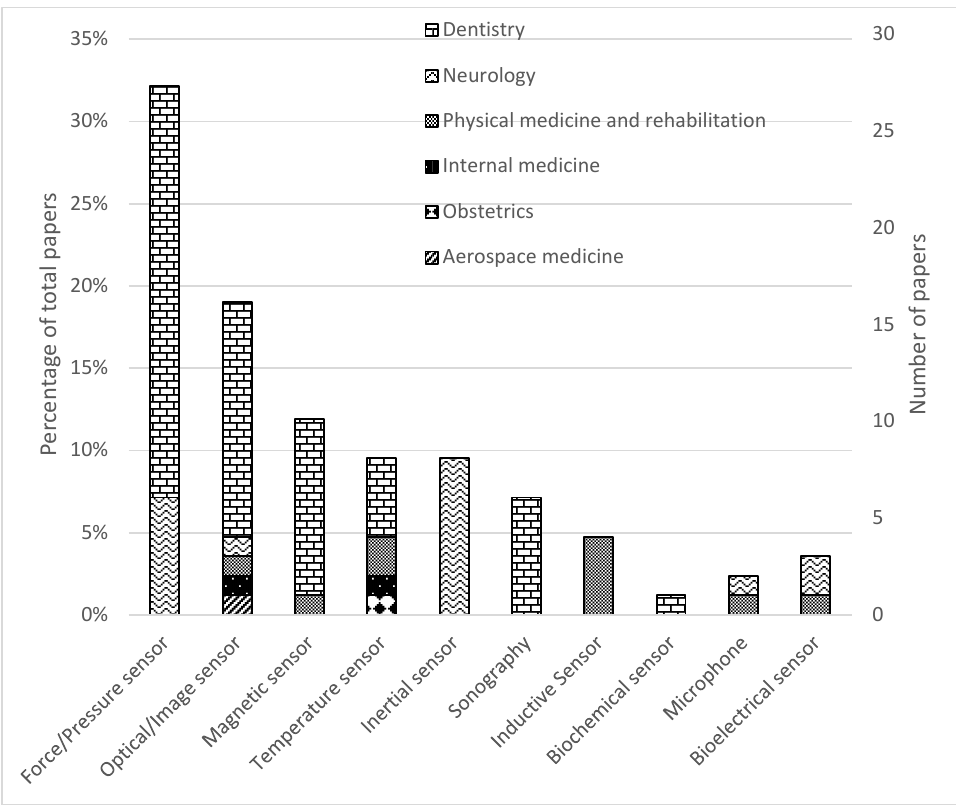
Figure 3. Distribution of papers by field of study and sensor technology. Forty-four full texts were not retrieved. Attempts to contact the authors were made, but no responses were received.